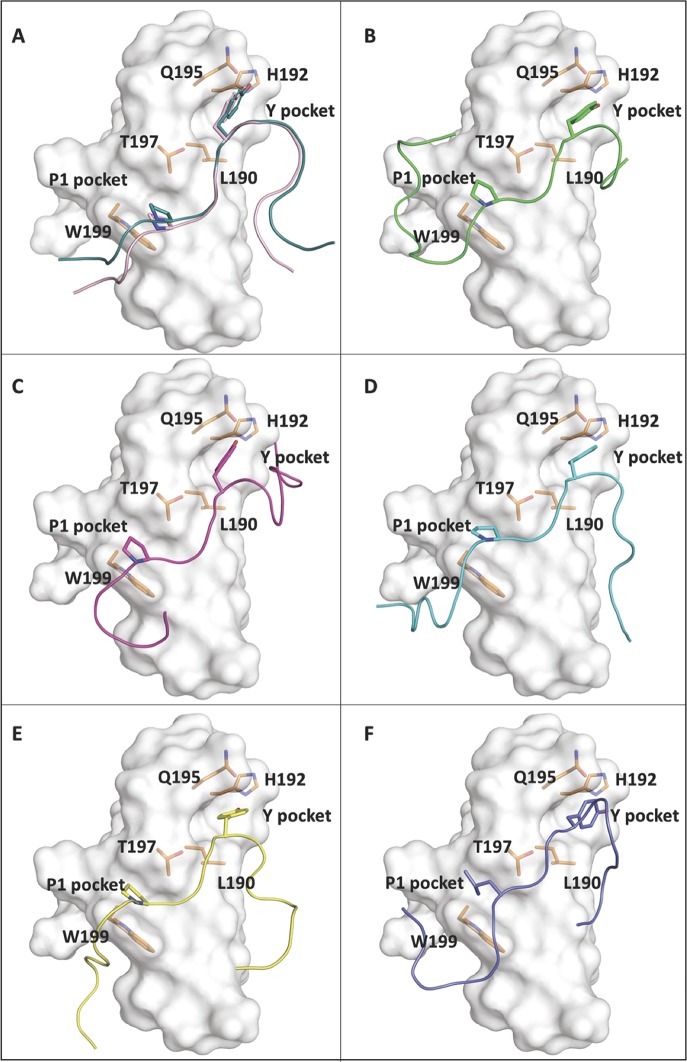
Protein-peptide docking poses.The protein-peptide docking poses are shown for: A) the NMR structure of YAP WW1-smad7 peptide (GESPPPPYSRYPMD) complex (light pink color) and the docking pose of smad7 peptide (control, deep teal color), B) YAP WW1 domain-eVP40 peptide (MRRVILPTAPPEYMEAI) (green), C) YAP WW1 domain-mVP40 peptide (MQYLNPPPYADHGANQL) (magenta), D) YAP WW1 domain-Amot peptide 1 (GMEHRGPPPEYPFKGMP) (cyan), E) YAP WW1 domain-Amot peptide 2 (QLMRYQHPPEYGAARPA) (yellow), and F) YAP WW1 domain-Amot peptide 3 (MQNNEELPTYEEAKVQ) (purple). The first Proline (P1) of the PPxY motif (or L of LPTY in Amot peptide 3) occupies the P1 pocket of YAP WW1 domain which is formed by T197 and W199, and the Y sidechain of the PPxY motif occupies the Y pocket (hydrophobic groove composed by L190, H192, Q195, and T197) of YAP WW1 domain.